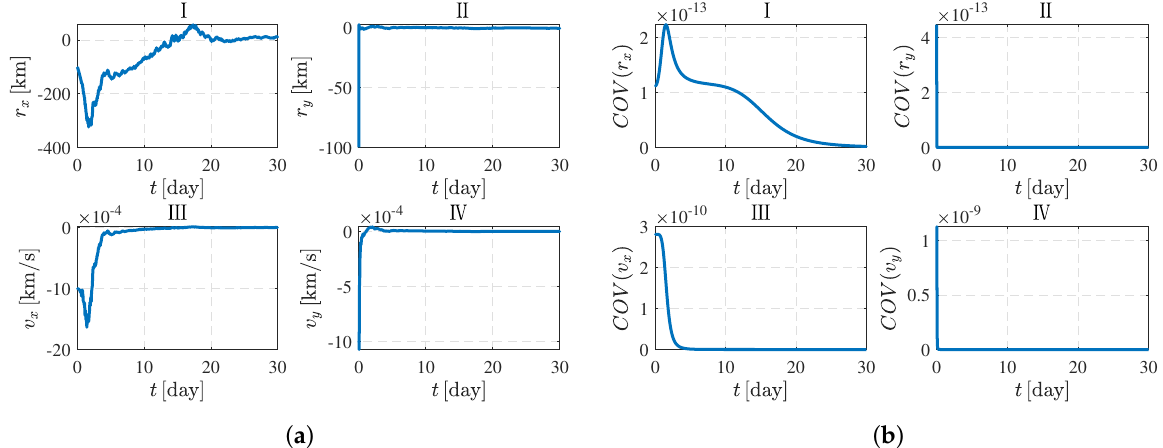
Figure 11. Navigation error results and covariance convergence curve. ( a ) Navigation error. ( b ) Co- variance convergence curve.